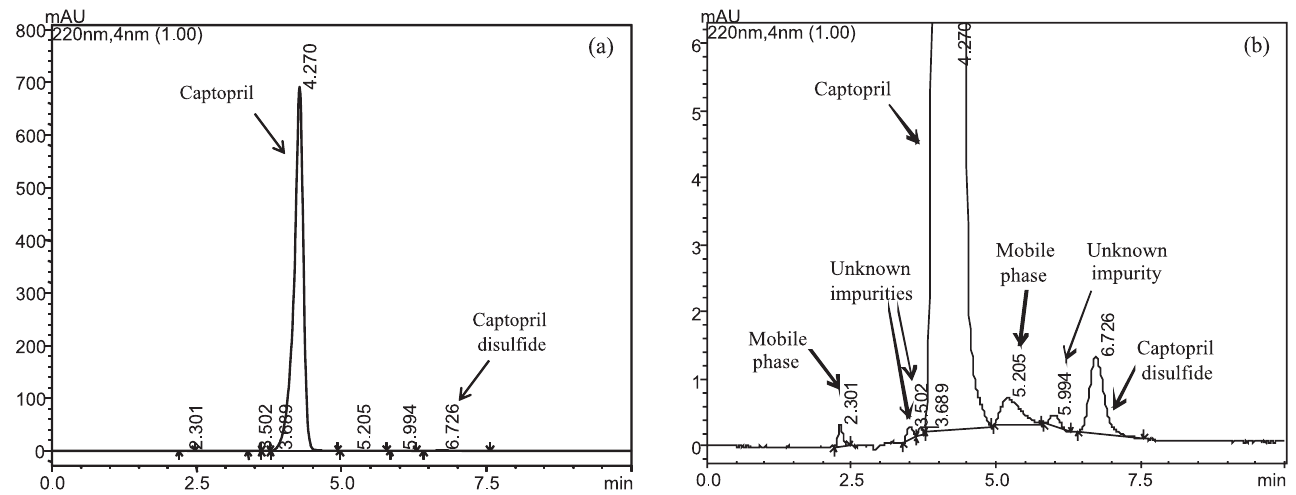
FIGURE 3 - Chromatogram of captopril candidate CRM (500 µg/g) (a) in full scale and (b) in enlarged view, showing the